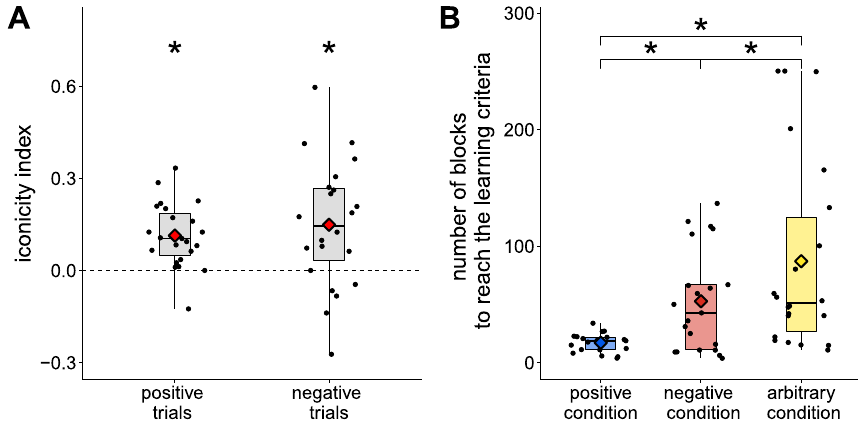
Figure 2. Results (Experiment 1). ( A ) Early iconicity bias. The iconicity index is the difference score between the proportion of iconic (positive) responses and participants’ expected performance (measured as the performance in neutral trials in the arbitrary condition where both or none of the target objects shared a dimension with the cue, and taken to be 50% in the positive and negative conditions), computed at the beginning of each condition (first 10% of trials to complete this condition). Each dot represents the measure for a participant in a given condition. Consistent with the presence of a bias towards iconic responses, baboons initially displayed an above-chance preference for iconic responses (positive iconicity index), regardless of the feedback they received (that is, for both positive and negative trials). Asterisks denote statistical significance ( > 0 ). ( B ) Global negation effect. Average number of blocks to reach the learning criterion in each condition (positive, negative, arbitrary). Diamonds show condition means, and each dot represents a participant. The positive condition was learned the fastest, and crucially the negative condition was learned faster than the arbitrary condition. Asterisks denote statistical